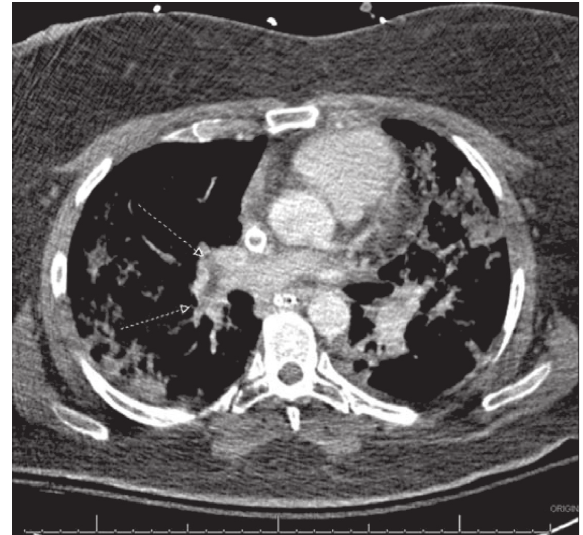
Figure 4: Computed